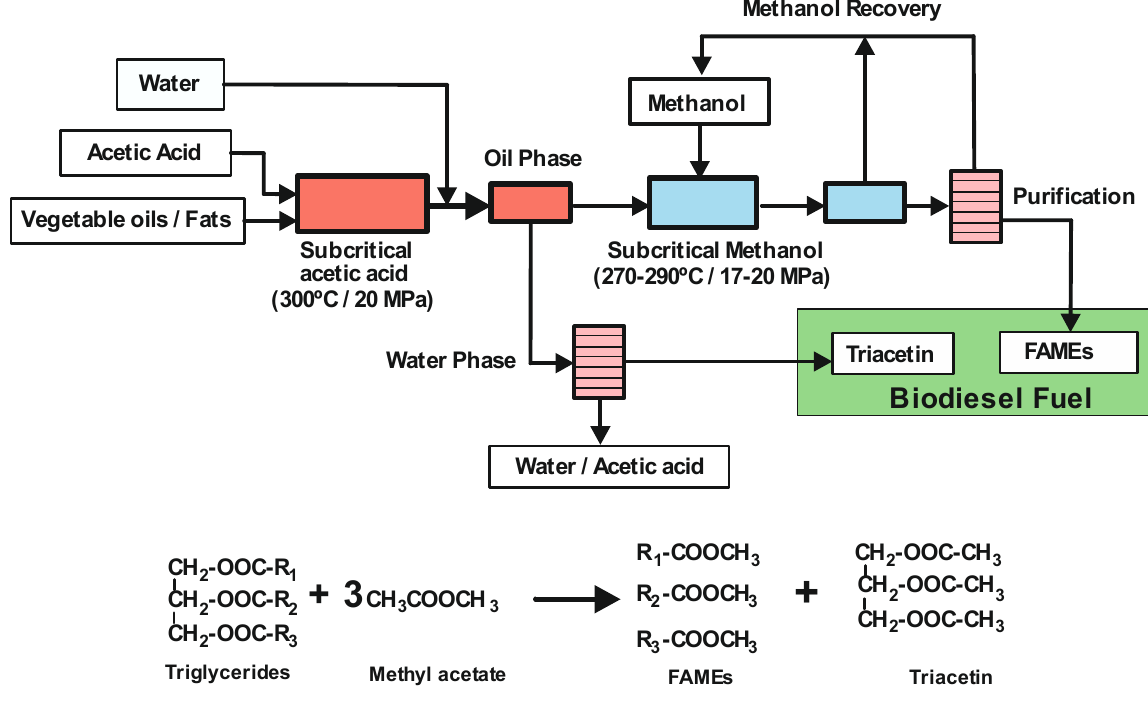
Figure 6. Biodiesel synthesis by the two-step supercritical approach. Reaction equations